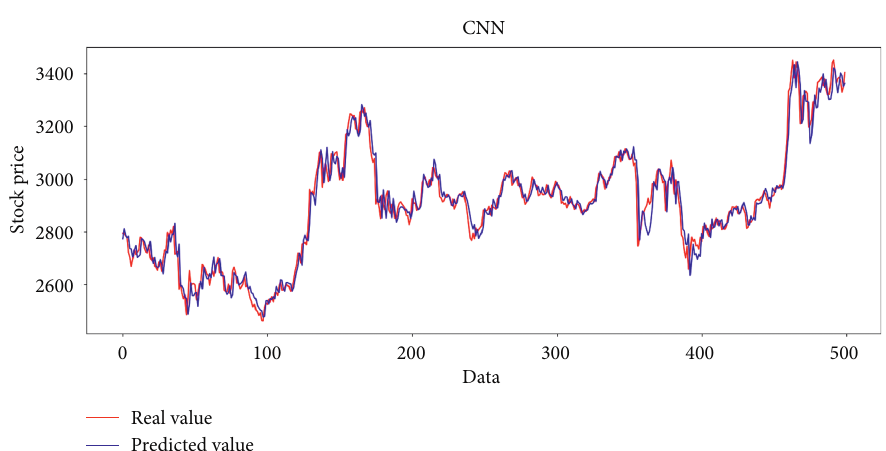
Figure 6: Comparison of the predicted value and the real value for CNN.